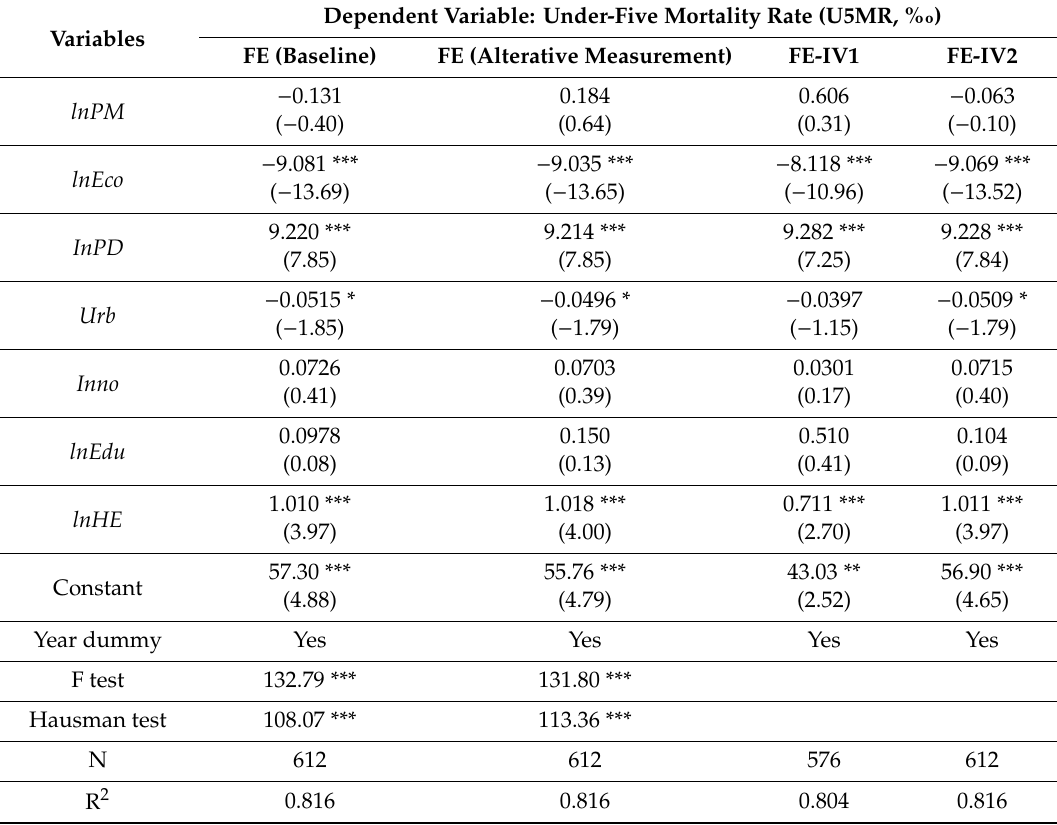
Table 6. Estimation result of developed